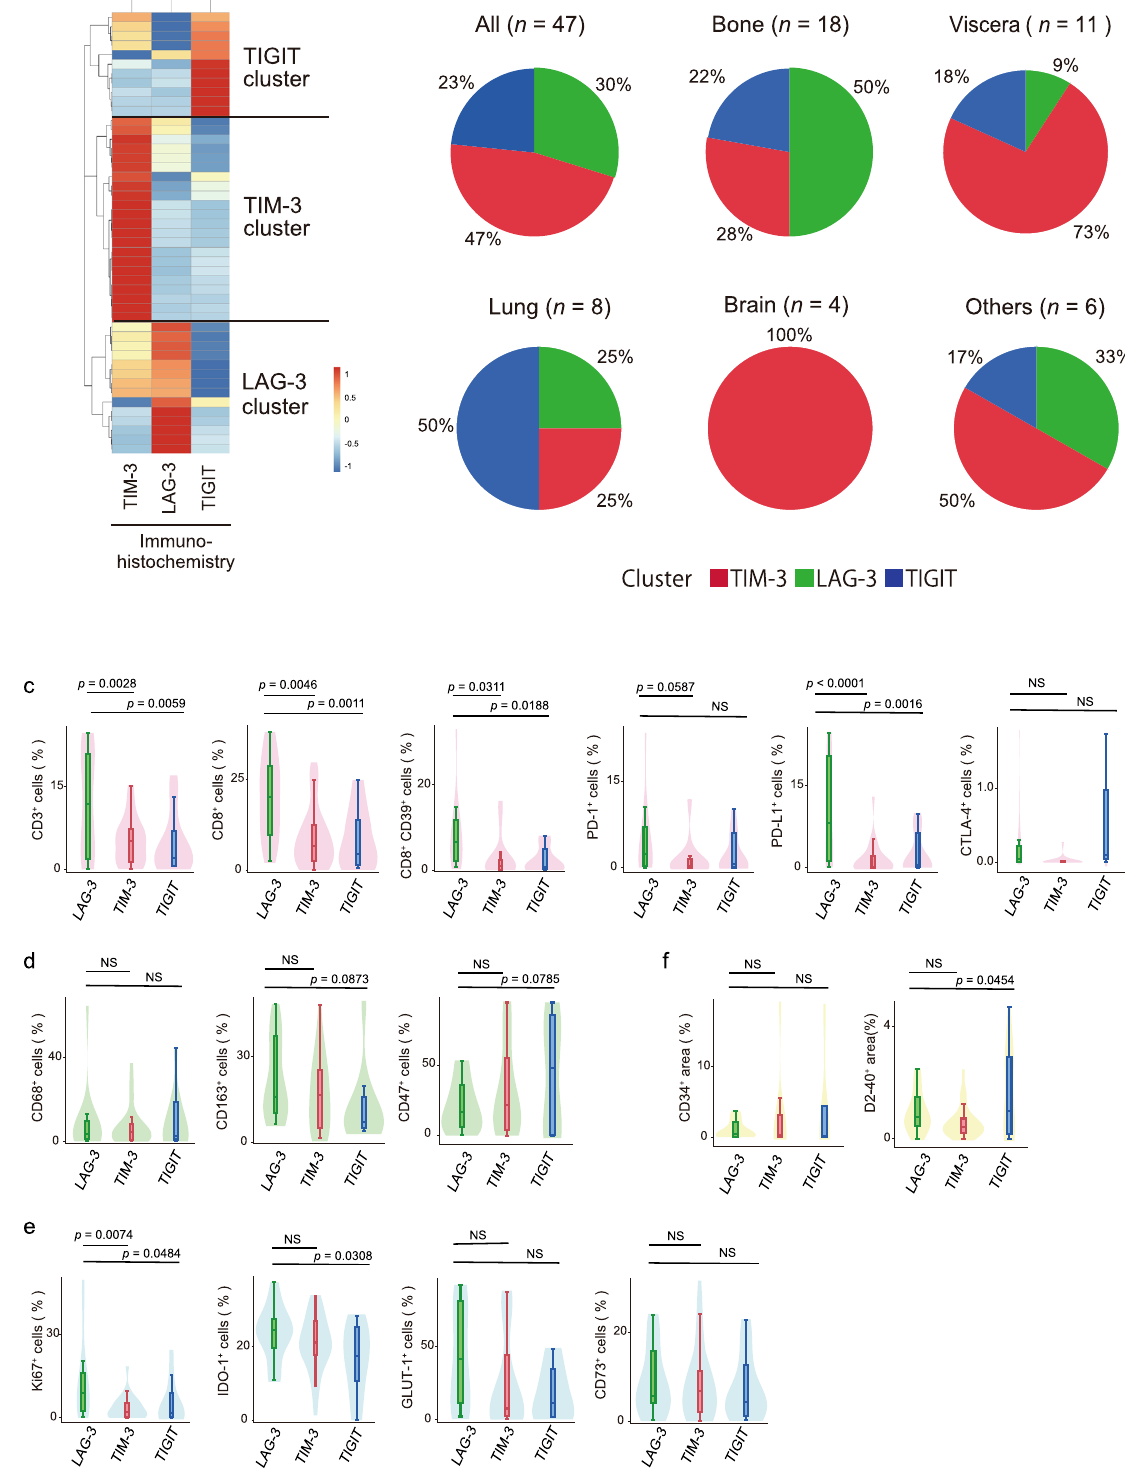
Fig. 3 Metastasis-speci fi c differences underlying the phenotypic signatures of the new IRs (LAG-3, TIM-3, and TIGIT). a Hierarchical clustering heatmap (low, blue; high, red) using positive-stained cell densities of LAG-3, TIM-3, and TIGIT in 47 metastatic ccRCC samples. Data were normalized prior to clustering. b Inferred IR cluster distributions obtained in ( a ) by metastatic region. c – f Positive cell densities and areas (CD34 and D2-40) in 47 metastatic ccRCC samples obtained from patients based on the three new IR clusters and the acquired immunity ( c ), innate immunity ( d ), inhibitory tumour metabolism ( e ), and vascular attribute ( f ) signatures. The lines within the boxes represent the medians, the upper and lower ends of the boxes represent the upper and lower quartiles, and the bars represent the minimum and maximum values in 1.5 times the IQR. p values were determined with a two-tailed Mann – Whitney U -test. Source data are provided as a Source data fi